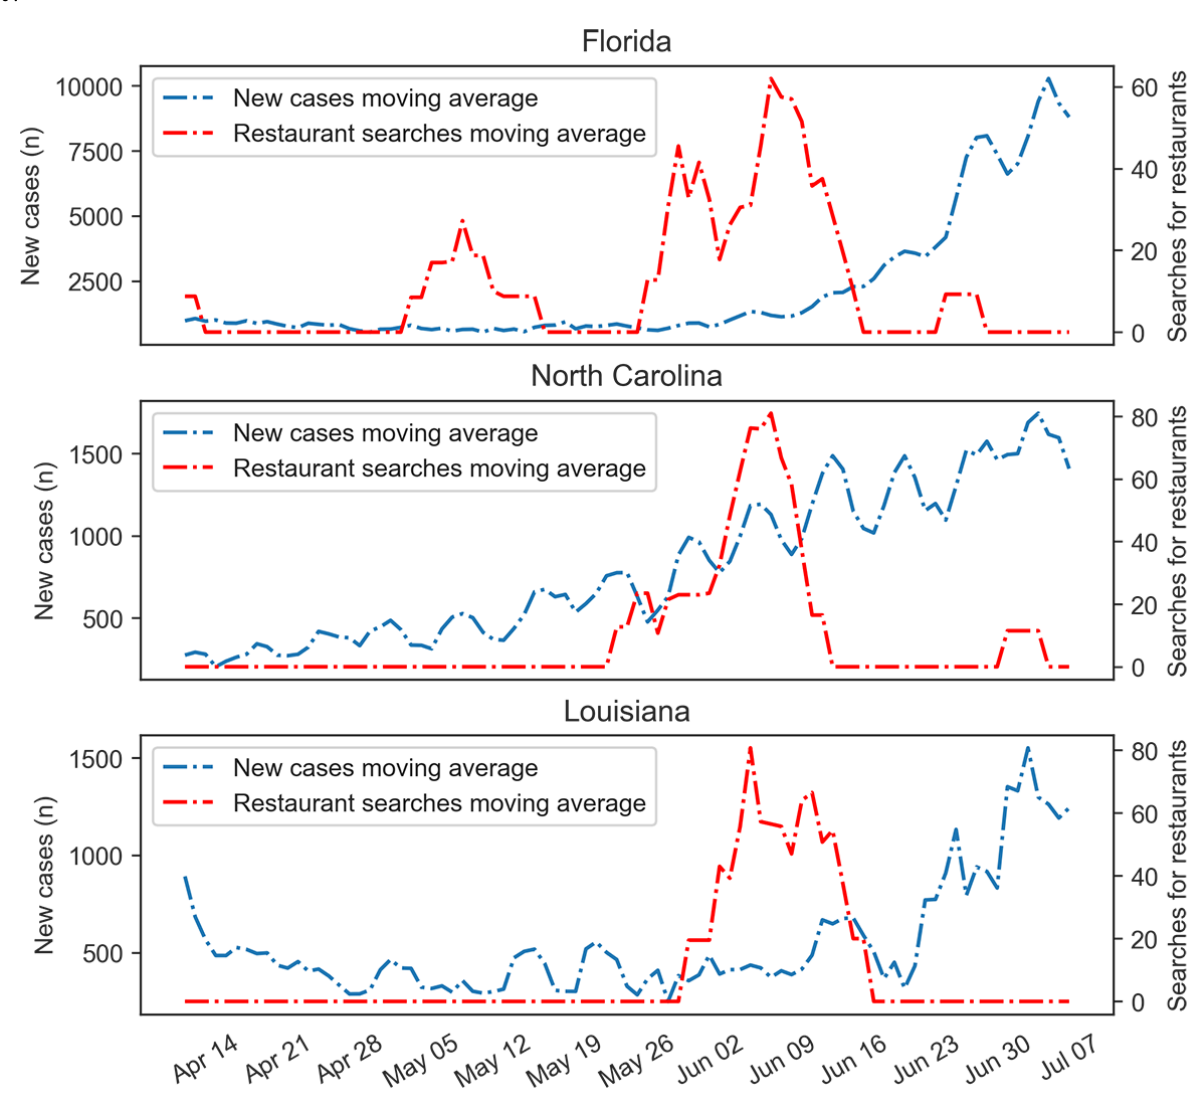
Figure 3. Comparison of restaurant search effects on daily new cases of COVID-19 in Florida, North Carolina, and Louisiana from April 9 to July